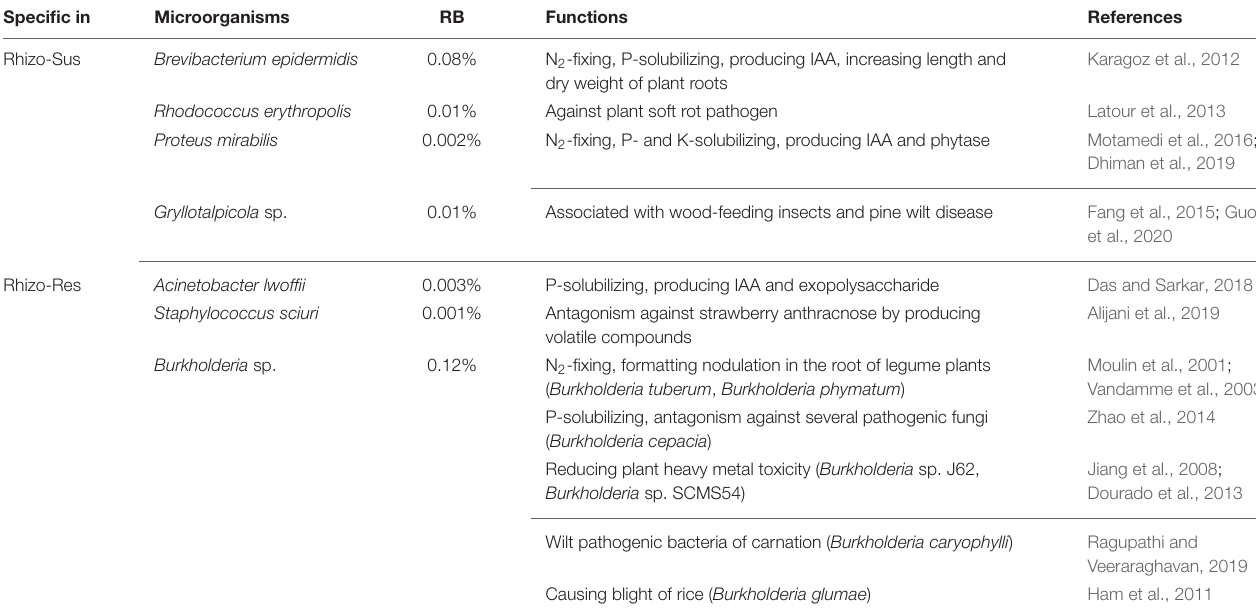
FIGURE 6 | Distribution of fungal functional groups (guild) and heatmap of fungal trophic modes in rhizosphere and bulk soil. Ternary plot of guild plotted based C. oleifera rhizosphere (Rhizo-Sus), C. yuhsienensis rhizosphere (Rhizo-Res), and bulk soil (BulkS) specificity. The circle size, color, and position indicate the average abundance, guild, and affiliation with Rhizo-Sus, Rhizo-Res, and BulkS (detected by Kruskal–Wallis analysis, p < 0.05), respectively. Rhizo-Sus 1–6 are Undefined Saprotroph, Endophyte–Fungal Parasite–Plant Pathogen, Ericoid Mycorrhizal, Endophyte–Lichen Parasite–Undefined Saprotroph, Endomycorrhizal–Plant Pathogen–Undefined Saprotroph, and Animal Pathogen–Endophyte–Plant Saprotroph–Soil Saprotroph, respectively. Rhizo-Res 1–6 are Arbuscular Mycorrhizal, Undefined Saprotroph-Undefined Biotroph, Endophyte–Plant Pathogen, Lichenized, Animal Pathogen–Endophyte–Lichen Parasite–Plant Pathogen–Wood Saprotroph, and Unassigned, respectively. BulkS 1 and 2 are Animal Pathogen–Fungal Parasite–Undefined Saprotroph and Dung Saprotroph–Undefined Saprotroph, respectively. The abundance of functions was normalized by Z-score method. The connecting lines on the left side describe the clustering of each function. The closer the color to yellow, the more dominant the function is. Pathotroph = receiving nutrients by harming host cells; symbiotroph = receiving nutrients by exchanging resources with host cells; saprotroph = receiving nutrients by breaking down dead host cells. The lowercase in each row of heatmap indicated the significant differences among Rhizo-Sus, Rhizo-Res, and BulkS (conducted using Wilcoxon rank sum test, p < 0.05), N = 12. TABLE 1 | Main known functions of bacteria specific for rhizosphere of C. oleifera (Rhizo-Sus) and C. yuhsienensis (Rhizo-Res). Specific